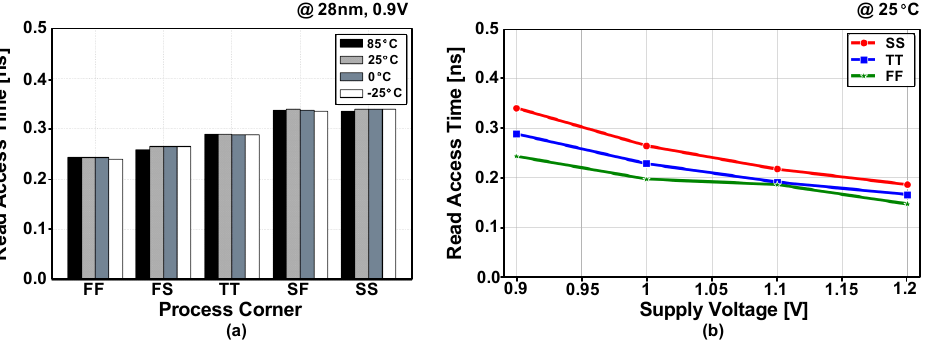
Figure 15. Post-layout simulated read-access times ( a ) depending on process corners and temperatures and ( b ) across the supply voltage range with typical (TT), best (FF) and worst (SS) process corners.